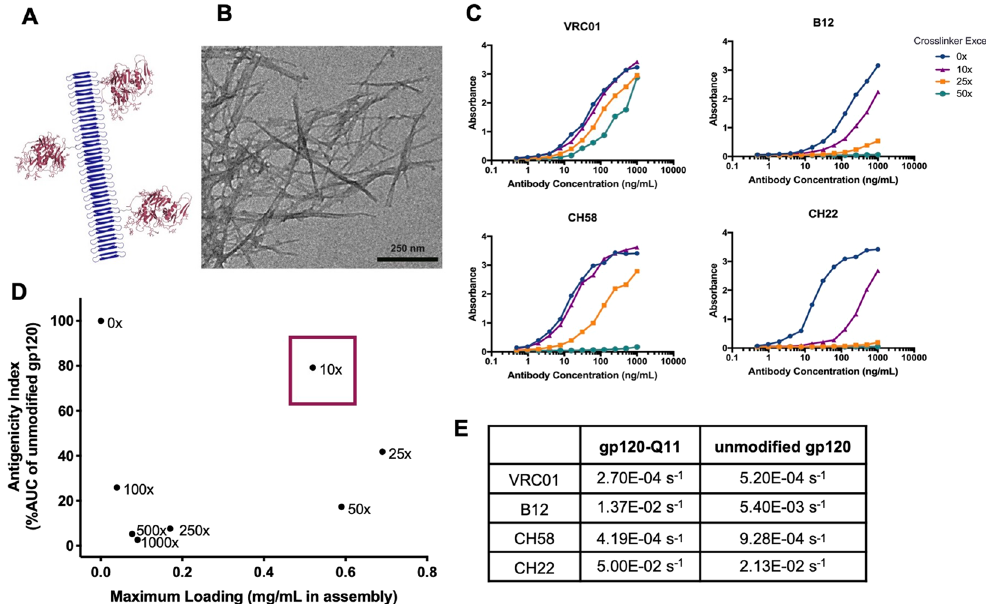
Figure 1. Nanostructure and antigenicity of nanofiber-gp120 conjugates. ( A ) Schematic representation of gp120 antigens (maroon) covalently linked to fibrillizing peptides (blue). ( B ) TEM image of gp120 nanofibers stained with uranyl acetate. ( C ) Binding of antibodies against VRC01, B12, CH58, and CH22 epitopes to gp120 nanofibers prepared with different molar ratios of crosslinking agent SMCC, measured by ELISA. ( D ) Representation of gp120 antigenicity and loading density on nanofibers with selected formulation (10×) boxed in red. Antigenicity index for each condition was calculated by adding the AUC of ELISA binding curves from VRC01, B12, CH58 and CH22, then dividing by the sum AUC of unmodified gp120. ( E ) Dissociation rate constants